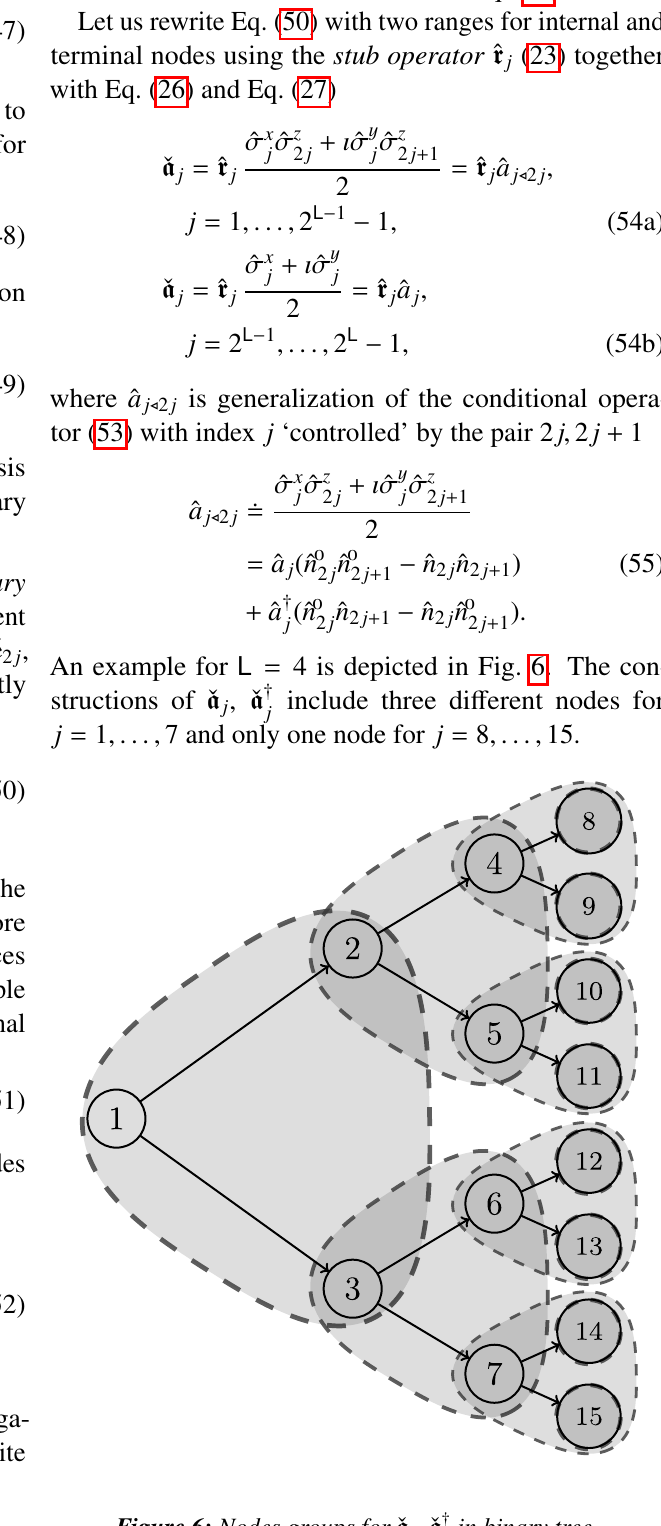
Figure 6: Nodes groups for ˇ a j , ˇ a †